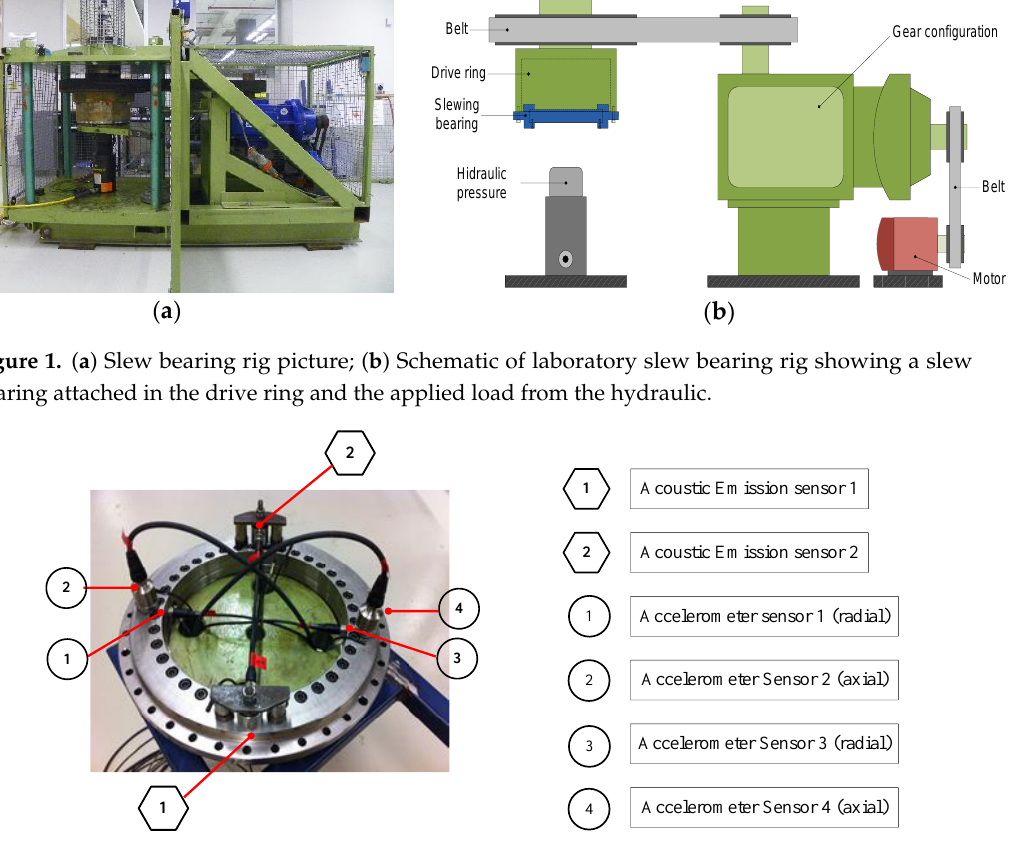
Figure 2. A detailed sketch of the location of four accelerometers and two AE sensors on slew bearing.